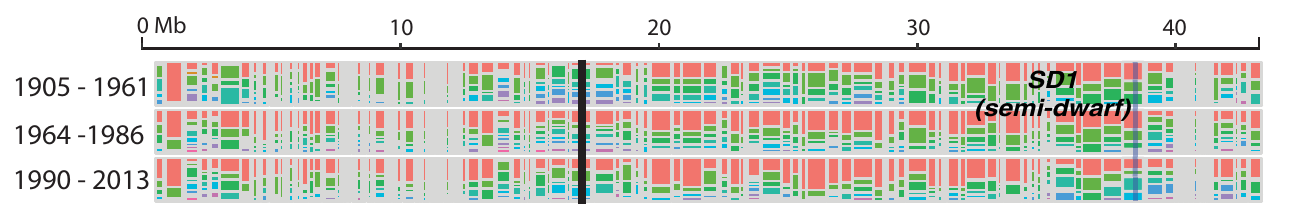
Fig 5. The select-ome of US rice breeding. Chromosome 1 is shown as representative. The chromosome is divided into LD blocks and haplotypes within those blocks are colored based on red being the most frequent across the three time periods defined on far left. Semi-dwarf locus, a known target of selection, is labeled. Sparse regions represent very small LD blocks. All chromosomes are plotted in S8 Fig . See https://gbru-ars.shinyapps.io/HaploStrata/ for fully interactive